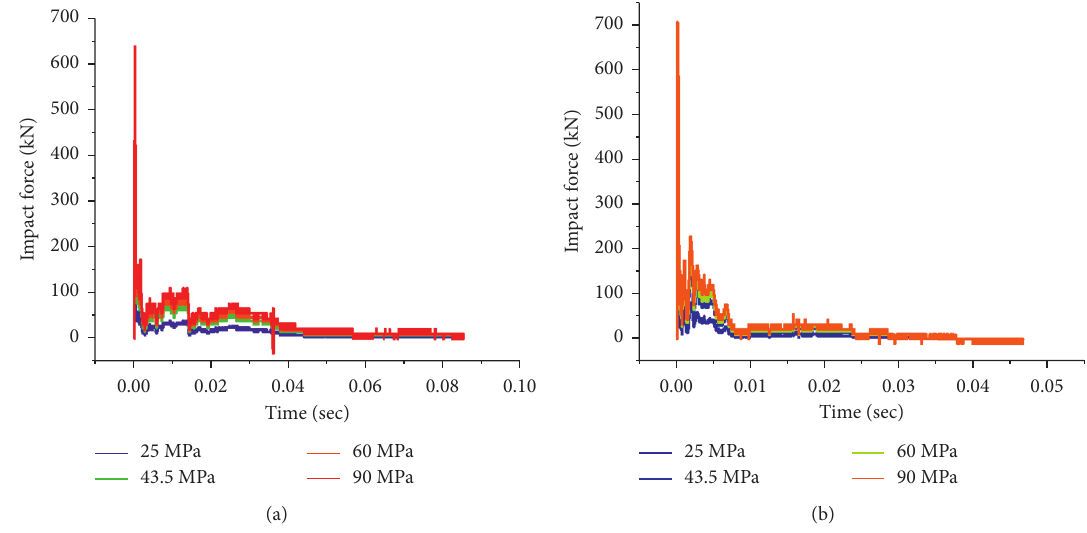
Figure 17: Effect of concrete strength on the impact time history curve of (a) FH2 specimen and (b) FH2-H1 specimen.